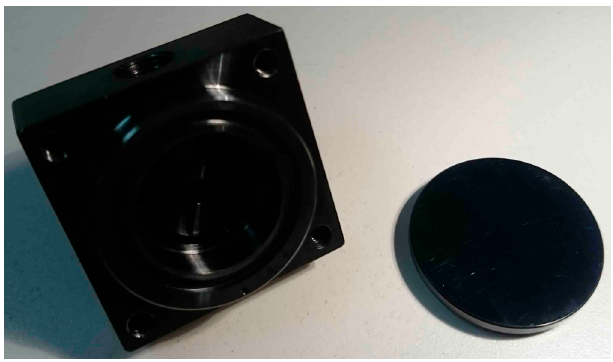
Figure 7. Pump body and cover after ‘diamond-like-carbon’ DLC Molt coating. Table 3. DLC Molt technical characteristics.